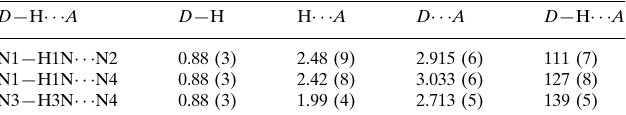
Hydrogen-bond geometry (A˚ , (cid:2)